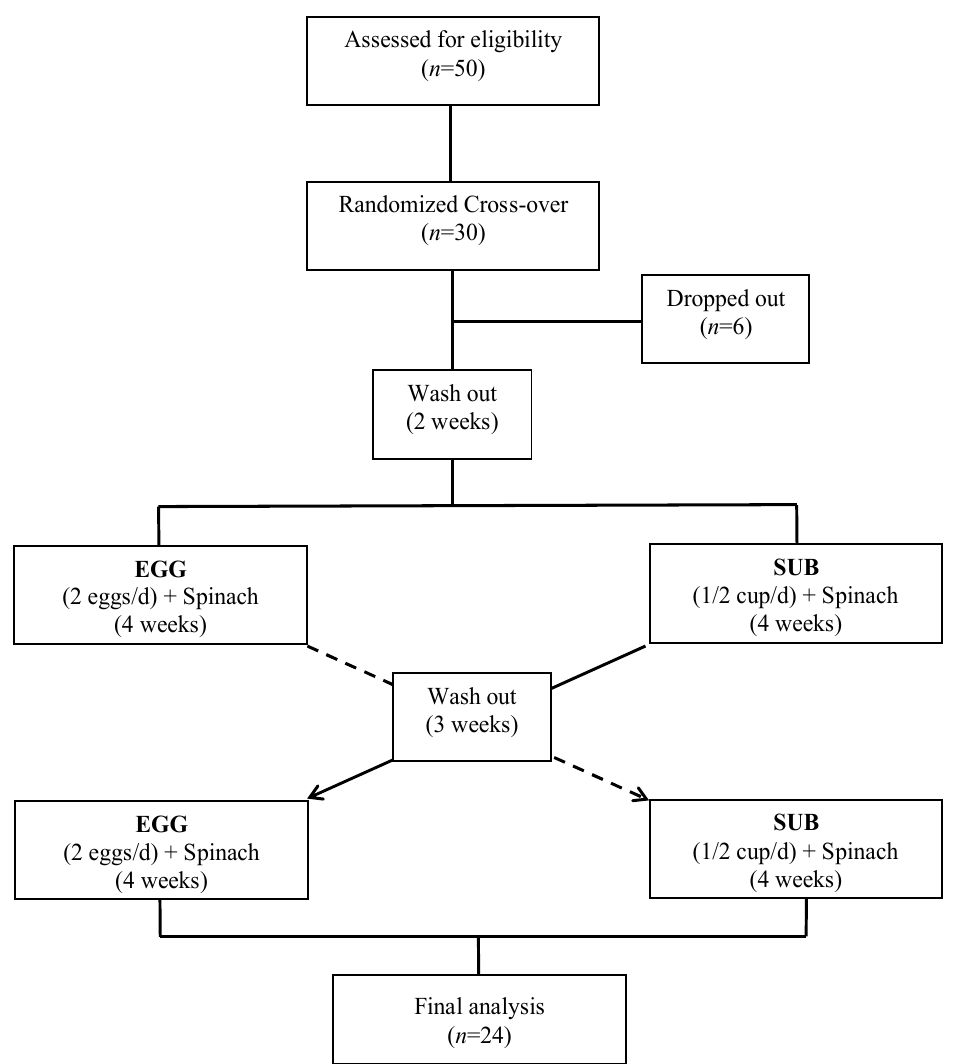
Figure 1. Experimental design. Participants underwent a 2-week washout period before being randomly allocated to either 2 eggs/d or equivalent egg substitute (1/2 c/d) for 4 weeks. Following a 3-week washout period, they were assigned the alternate treatment.